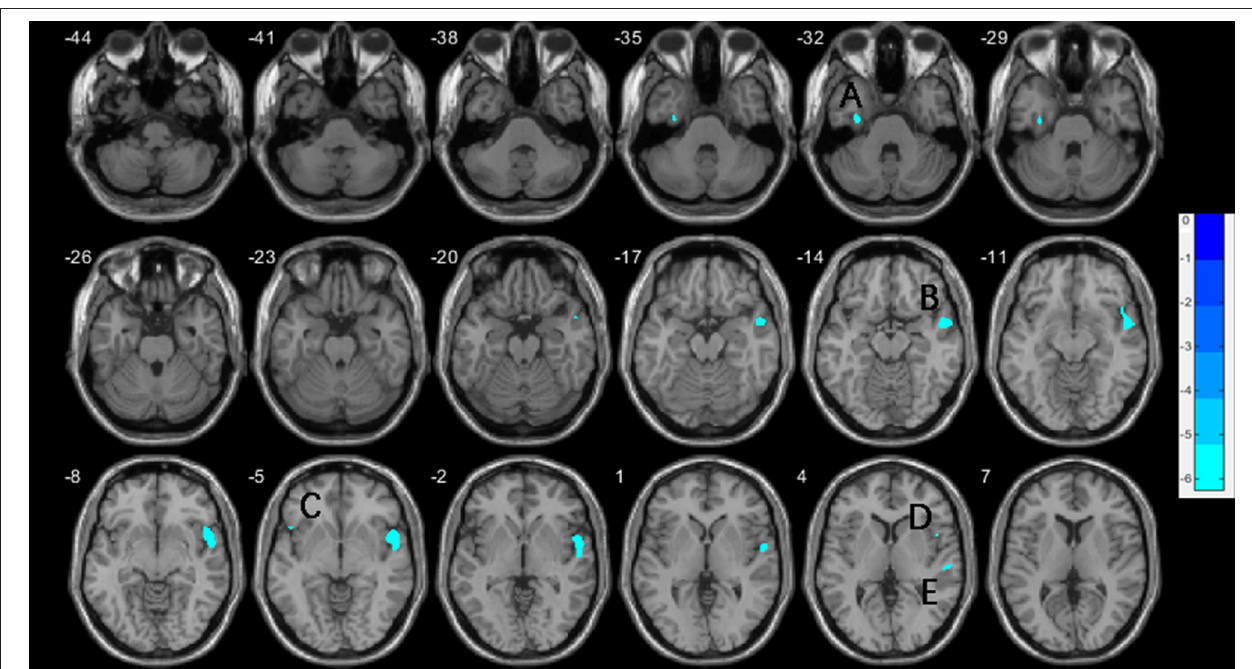
FIGURE 1 | Decreases of gray matter volume in the vSZ group compared to HCs, with age, education, and TIV controlled. (A) left fusiform gyrus; (B) right superior temporal gyrus; (C) left inferior frontal gyrus, orbital; (D) right inferior frontal gyrus, operculum; (E) right superior temporal gyrus. TIV, total intracranial volume.